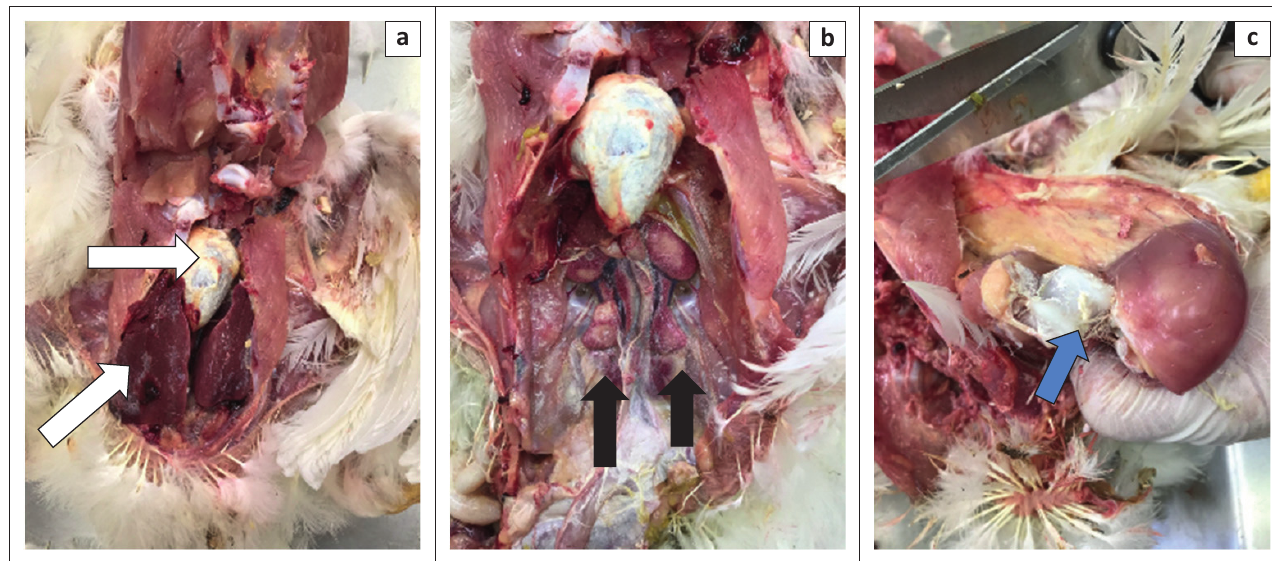
FIGURE 1: Gross pathology findings in a test group bird that succumbed approximately 48 h following intravenous administration of diclofenac. (a) Visceral gout with uric acid accumulation on the serosal surface of the liver and pericardium (white arrows), (b) nephrosis of the kidneys evident as pale and yellowish (black arrow) and (c) uric acid accumulation in the tibeo-tarsal joint indicative of articular gout (blue